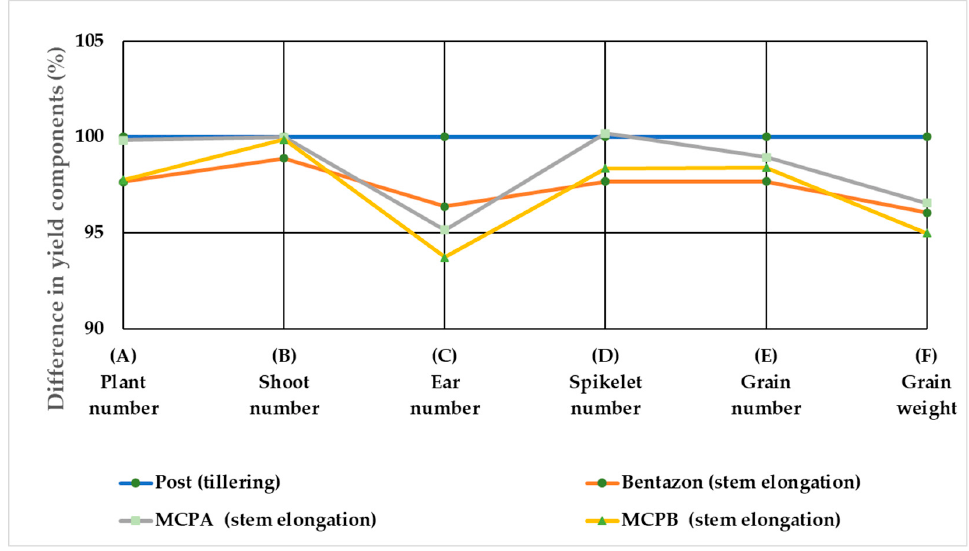
Figure 7. The effect of the timing of post-emergence weed management without pre-emergence treatment on the development of winter wheat ( Triticum aestivum L.), over an average of 2 years.